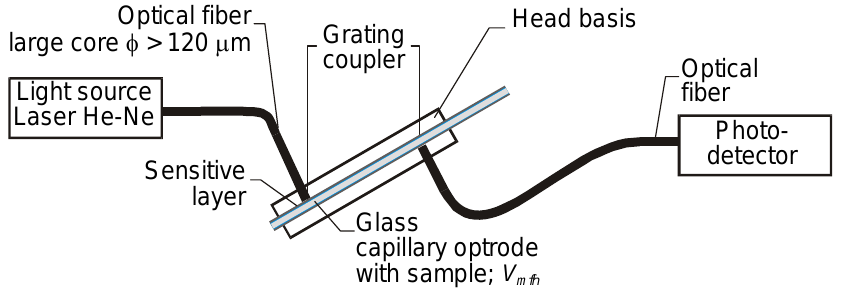
Figure 7. Optical capillary evanescent field sensor with sensitive layer intended for monitoring transfluent